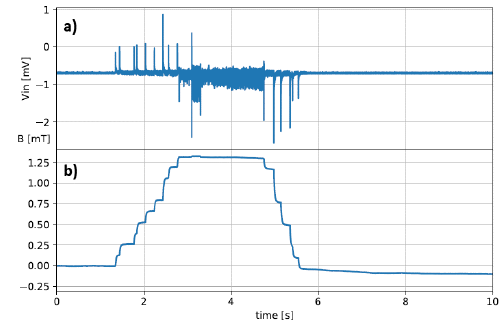
Figure 22. Test of numerical integrated signal from an actual probe with real field applied: direct acquired signal in ( a ) and numerical integration result in ( b ).